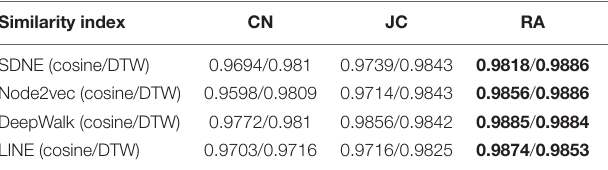
TABLE 6 | Prediction results under different similarity indexes (the top 5% of the Human protein similarity network). Similarity